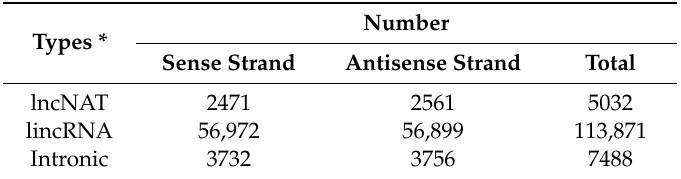
Table 1. Number of major types of lncRNAs.